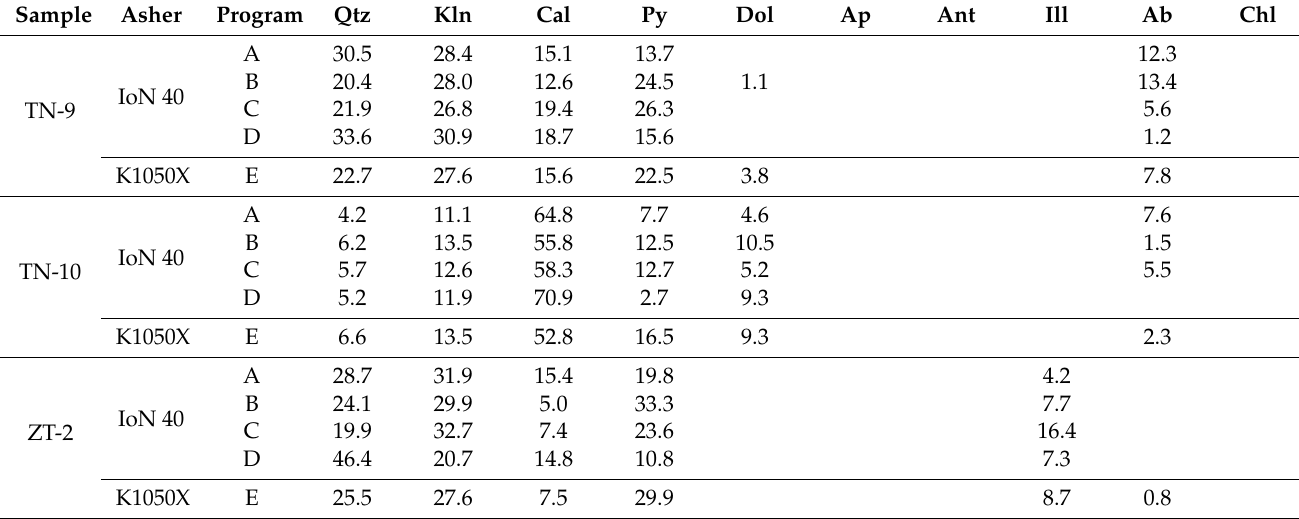
Table 6. Mineral compositions of LTAs determined by XRD and Siroquant (wt%, on organic matter- free basis).